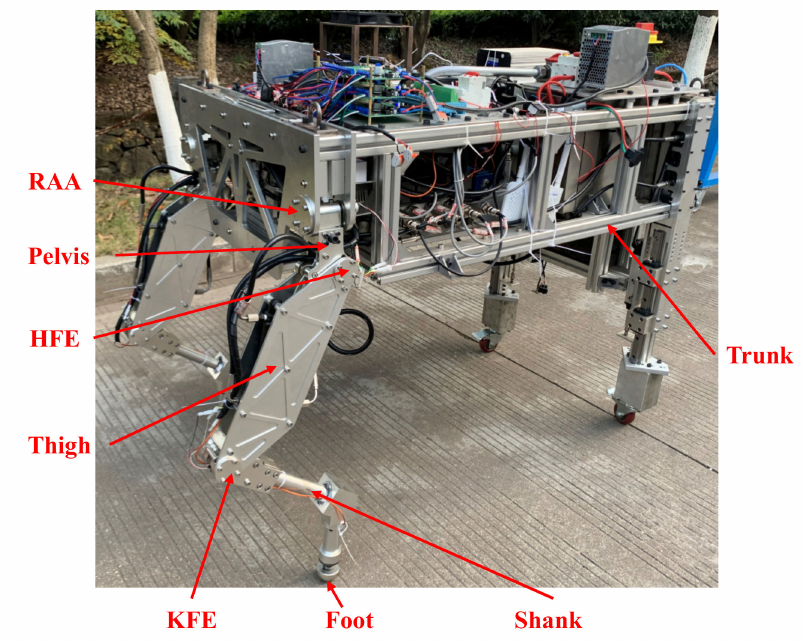
Figure 1. The quadruped wheeled-legged robot WLBOT. (RAA: root abduction/adduction; HFE: hip flexion/extension; KFE: knee flexion/extension.).